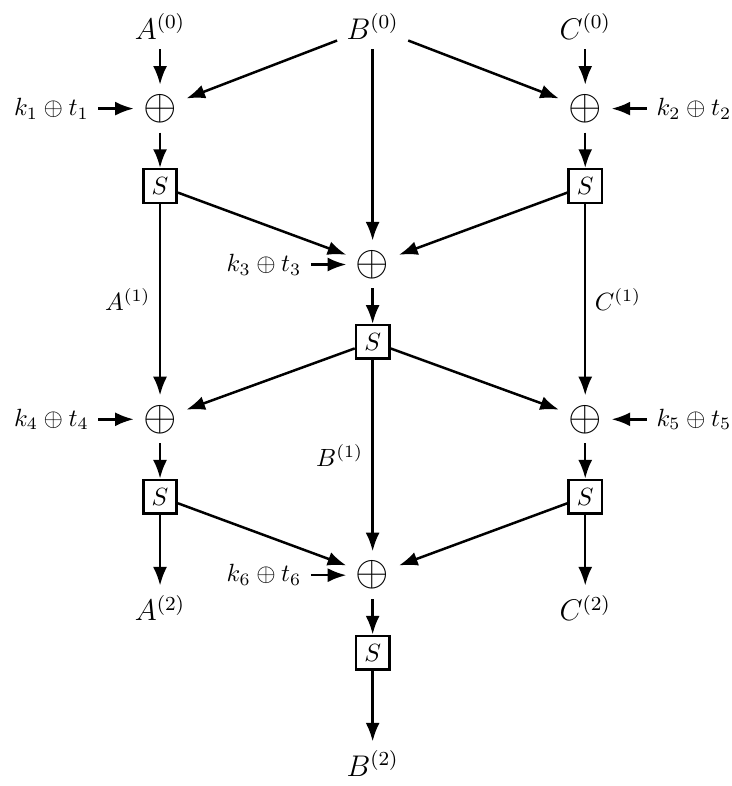
Figure 1: The first two rounds of the SoDark